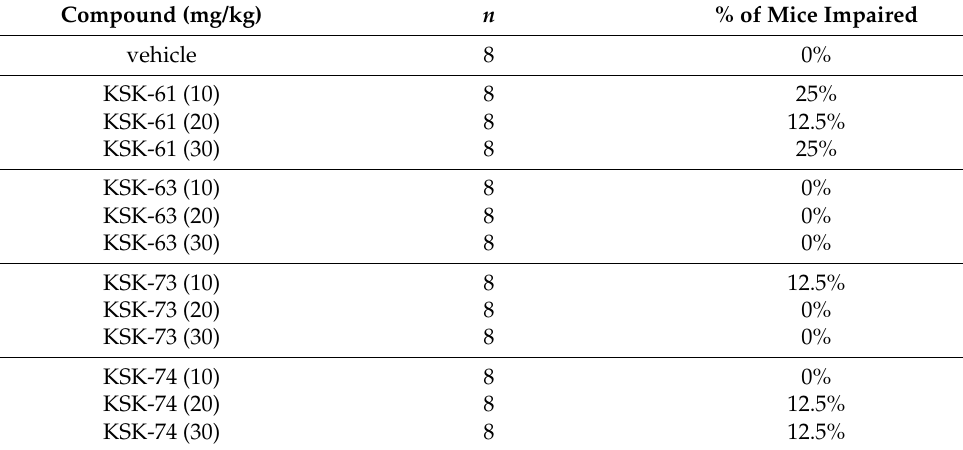
Table 1. The effect of tested compounds on motor coordination in the chimney test. Compound (mg/kg)